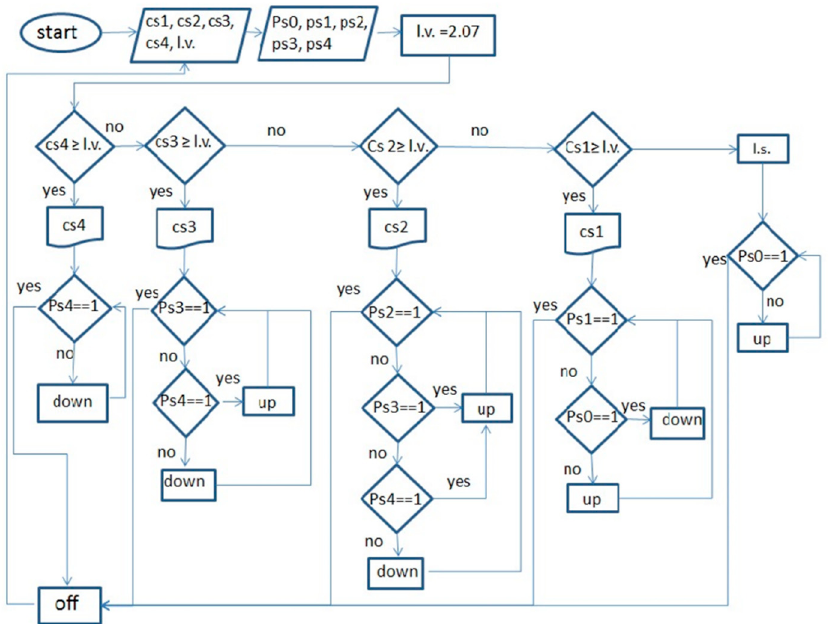
Figure 3. Flowchart for determining the hardpan layer, selecting the appropriate depth, activating the solenoid valve, and confirming the hydraulic jack position based on sensor data (cs1: compaction sensor at 10 cm depth, …, l.v.: pressure limit value (2.07 MPa), Ps0: zero position sensor on the rail (transport position), Ps1: position sensor that indicates the subsoiler depth in 10 cm, …, “up and down” are the settings of the solenoid valve that indicate the direction of the jack movement).